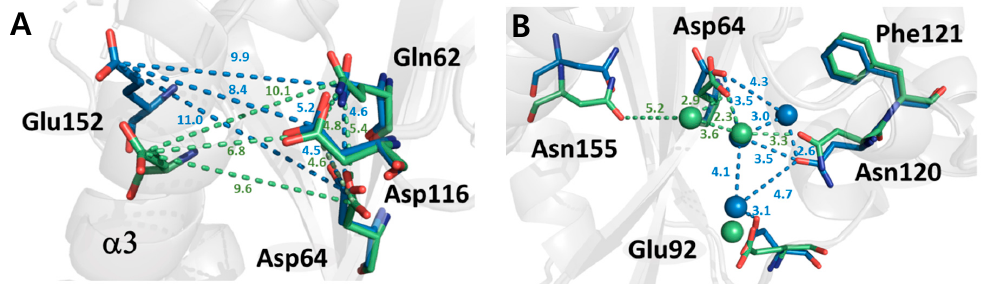
Figure 4. Comparison of the structures of the DDE triad (Asp, Asp, and Glu) and its vicinities. ( A ) Superimposed DDE triad region non-cryogenic (green) and cryogenic (blue) structures of HIV-1 integrase catalytic core domain. ( B ) Hydrogen bond network mediated by water molecules near the active site.